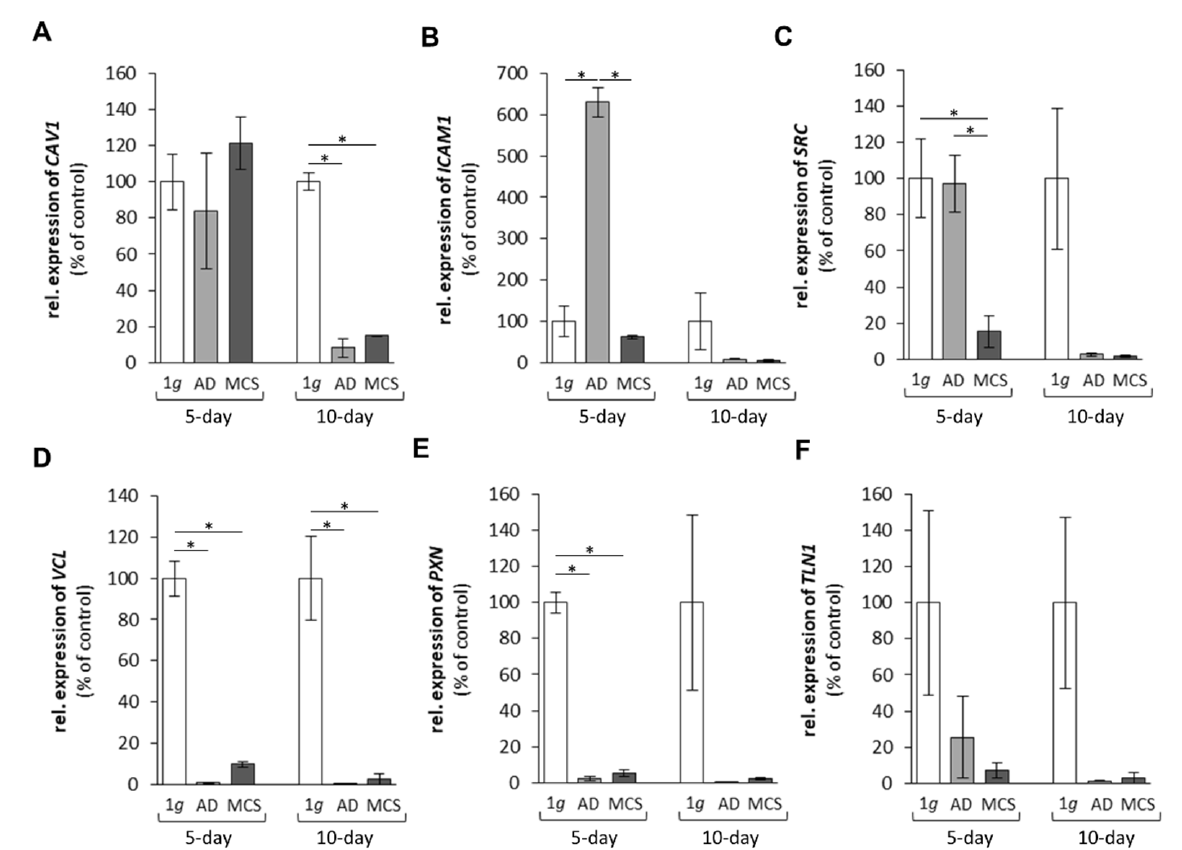
Figure 3. Gene expression of ( A ) CAV1 , ( B ) ICAM1 , ( C ) SRC , ( D ) VCL , ( E ) PXN and ( F ) TLN1 of FTC-133 follicular thyroid cancer cells grown in space on the International Space Station for 5 and 10 days. * p < 0.05 versus 1 g ground control cells. Values are presented as the mean ± standard deviation in percent of 1 g ground controls, which was fixed as 100% for each condition. AD corresponds to adherent cells; MCS corresponds to multicellular spheroids. 5-day spaceflight/1 g ground control samples, n = 3; 10-day spaceflight samples/1 g ground control, n = 2.